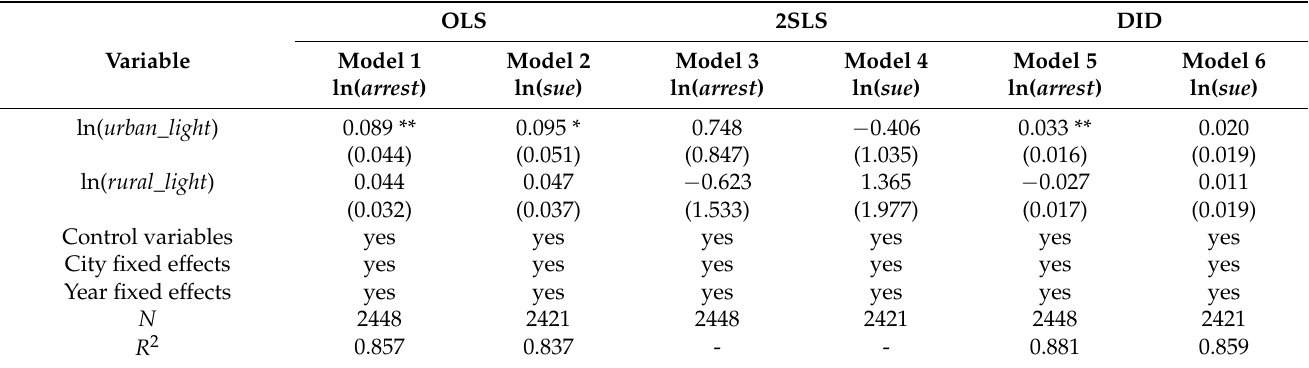
Table 7. Regression results based on urban and county